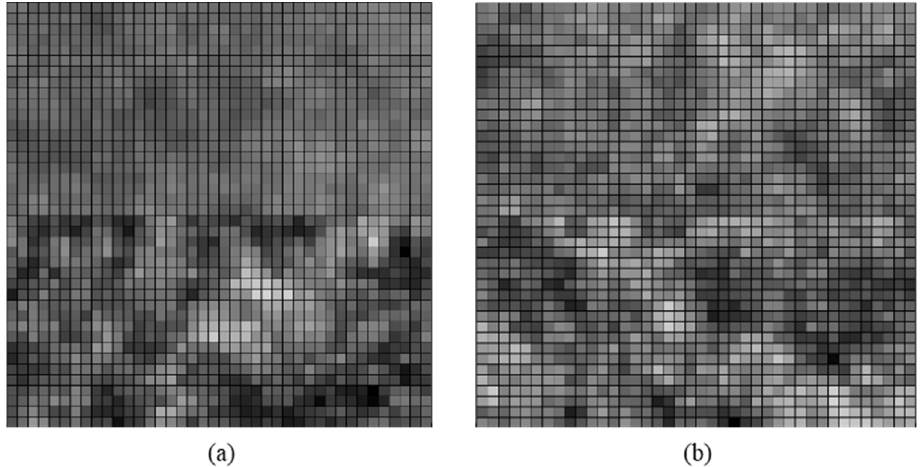
Figure 1. Gray scale diagram of hydraulic conductivity: ( a ) COV of hydraulic conductivity ( k ) = 0.1 and 0.3; ( b ) COV of k = 0.2 and 0.3.